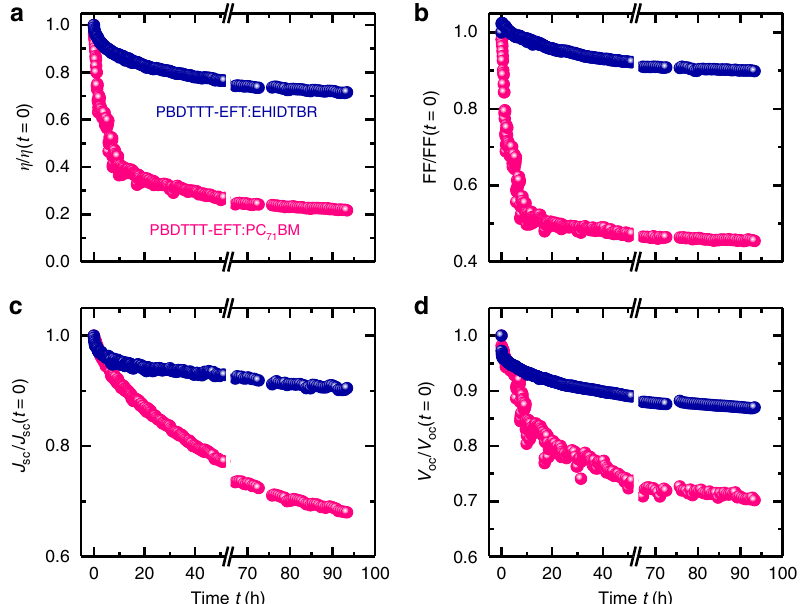
Fig. 4 Stability data for fullerene and nonfullerene devices. Time evolution of device performance and fi gures of merit of PBDTTT-EFT:EHIDTBR and PBDTTT-EFT:PC 71 BM solar cell devices under illumination of metal halide lamp in N 2